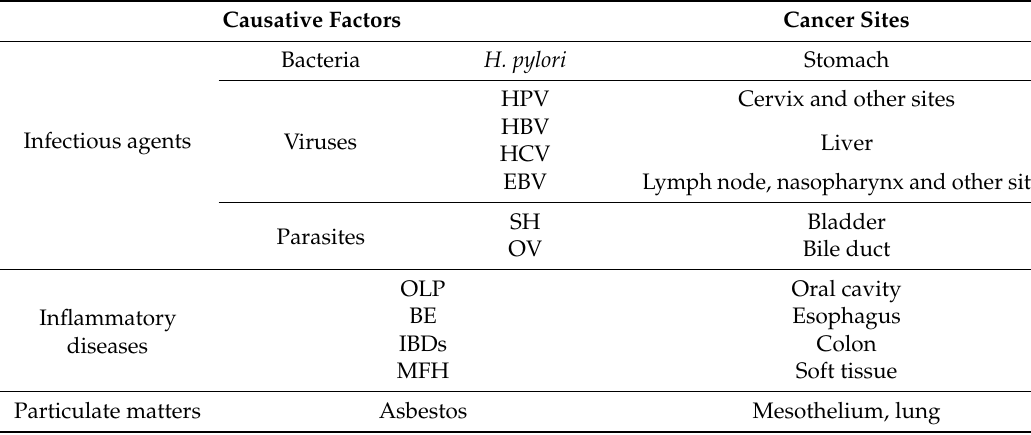
Table 1. Causative factors and cancer sites, in which 8-nitroguanine, inflammation-related DNA damage,